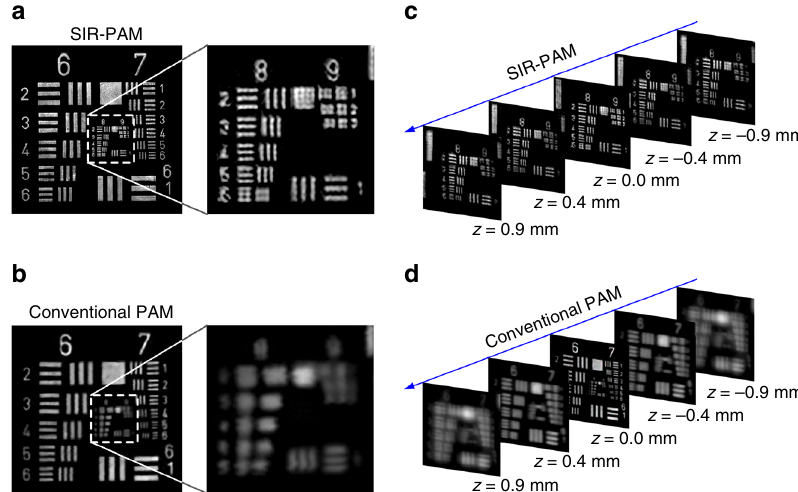
Fig. 3 SIR-PAM imaging of a USAF resolution target with spatially invariant resolution and improved lateral resolution. Images of a resolution target (1951 USAF) acquired with SIR-PAM a and conventional PAM b at the focal plane, respectively. c Images of groups 8 and 9 acquired by SIR-PAM at different imaging depths. The focal plane is located at z = 0.0 mm. d Images of groups 6 and 7 acquired by conventional PAM at depths corresponding to c . The results show that SIR-PAM is capable of achieving spatially invariant resolution and improved lateral in polar coordinates